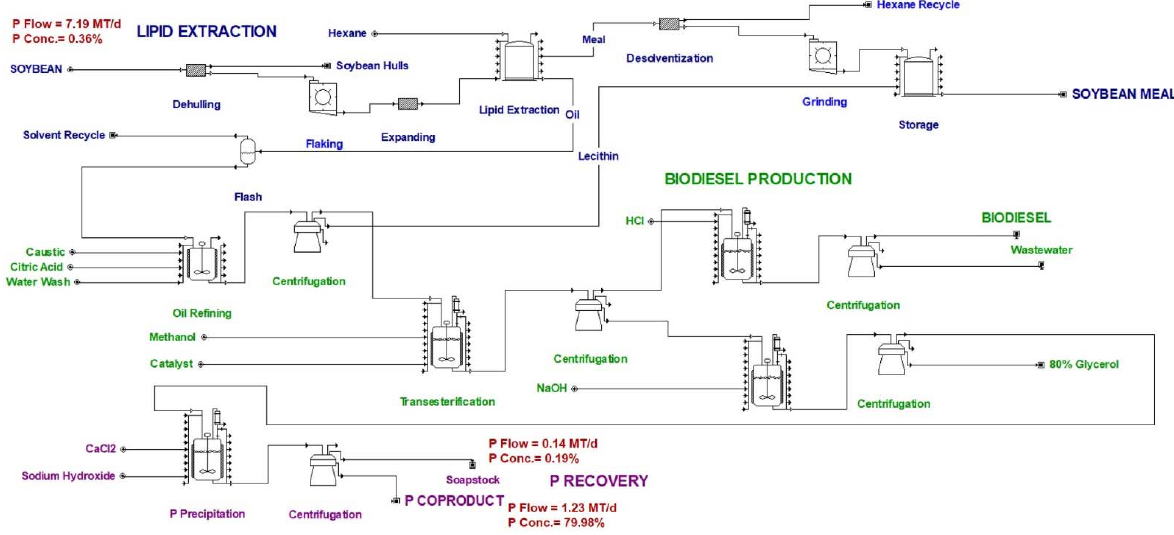
Figure 2. Schematic representation and P flows in the soybean biodiesel process with P recovery from soapstock (PRSS).